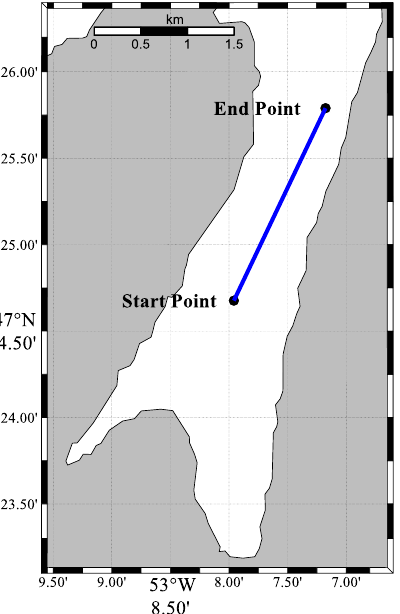
Figure 9. Trajectory of the glider in the mission of changing maximum dive depth based on a simplified fluorescence field.